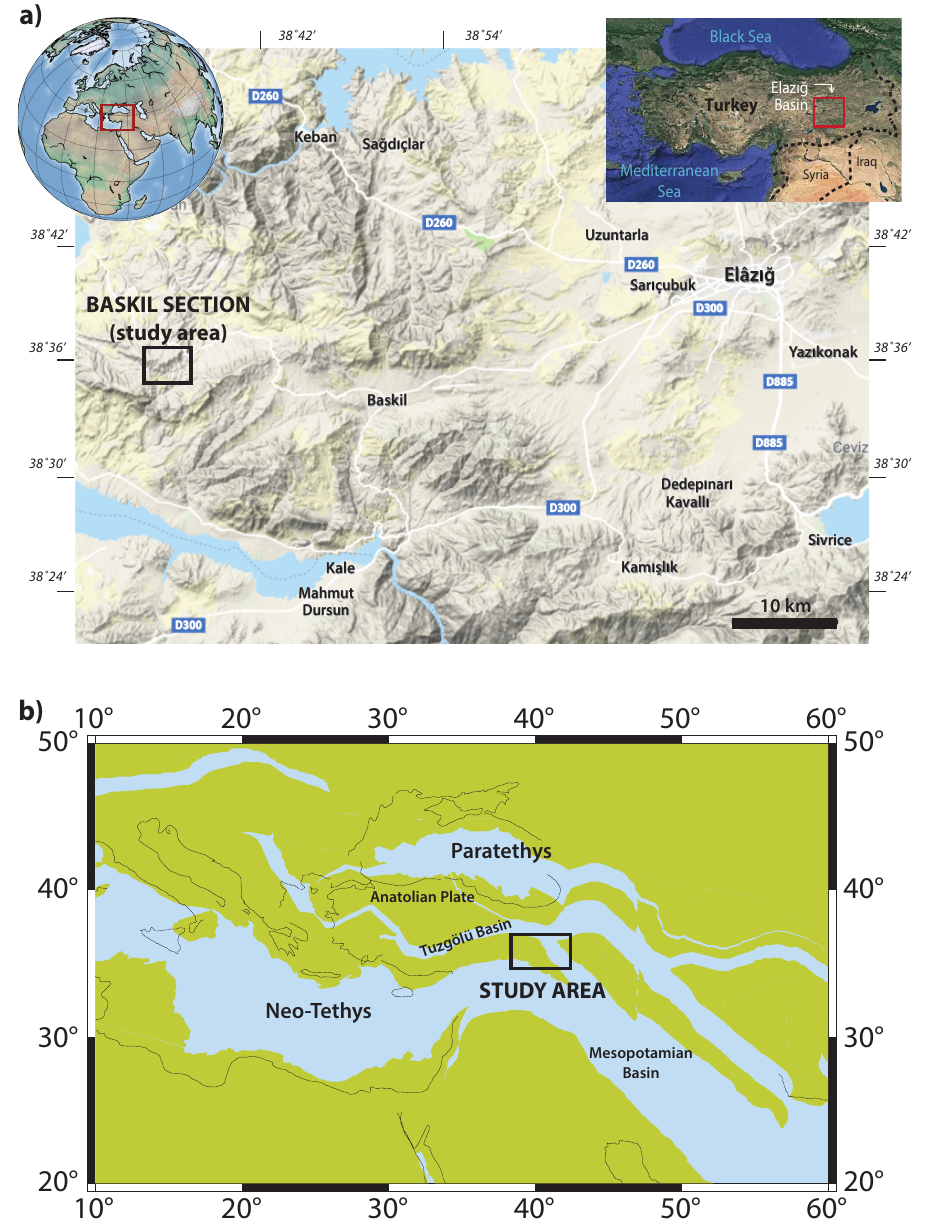
Figure 1. ( a ) Geographic maps showing the location of the studied area. The base of the terrain map is from Google Maps (Map data©2019 Google; https://www.google.com/maps/@38.6360375,38.927 7941,10z, accessed on 26 November 2021, the satellite map of Turkey at the top right corner is from Google Earth (Map data©2018 Google; https://www.google.com/maps/); the globe at the top left corner was made using Python 3.4.3-0 with Matplotlib59. ( b ) Paleogeographic reconstruction of the eastern part of the Neo-Tethys at ~40 Ma, showing the paleogeographic location of the studied area (generated with the ODSN Plate Tectonic Reconstruction Service, 2011; http://www.odsn.de/odsn/ services/paleomap/paleomap.html, accessed on 26 November 2021). Modified from